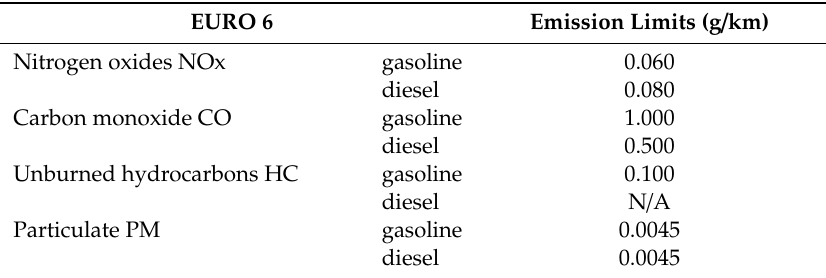
Table 30. EURO 6 directive.